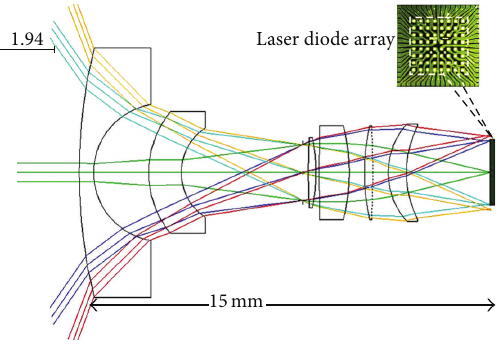
Figure 3: Optical layout of the